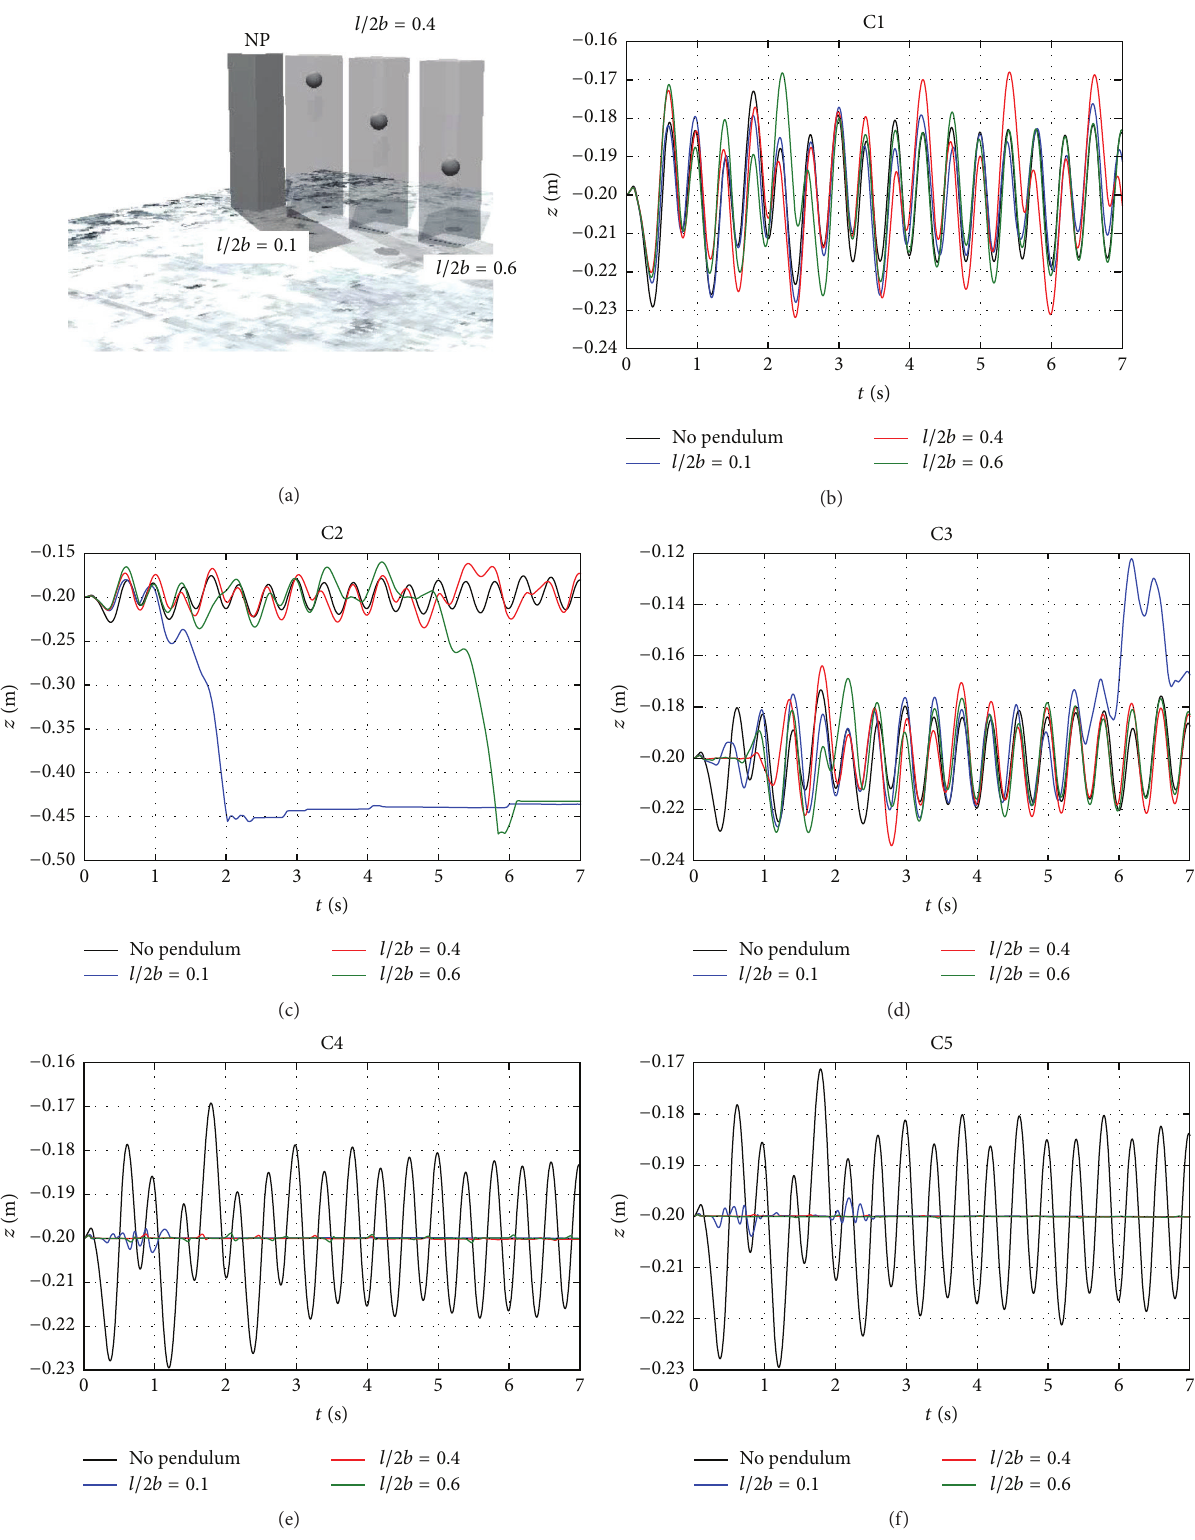
Figure 10: Multibody model and base-block relative motion amplitude ( 𝑧 ) under forced oscillations for cases C 1,. . . , C 5 of Table